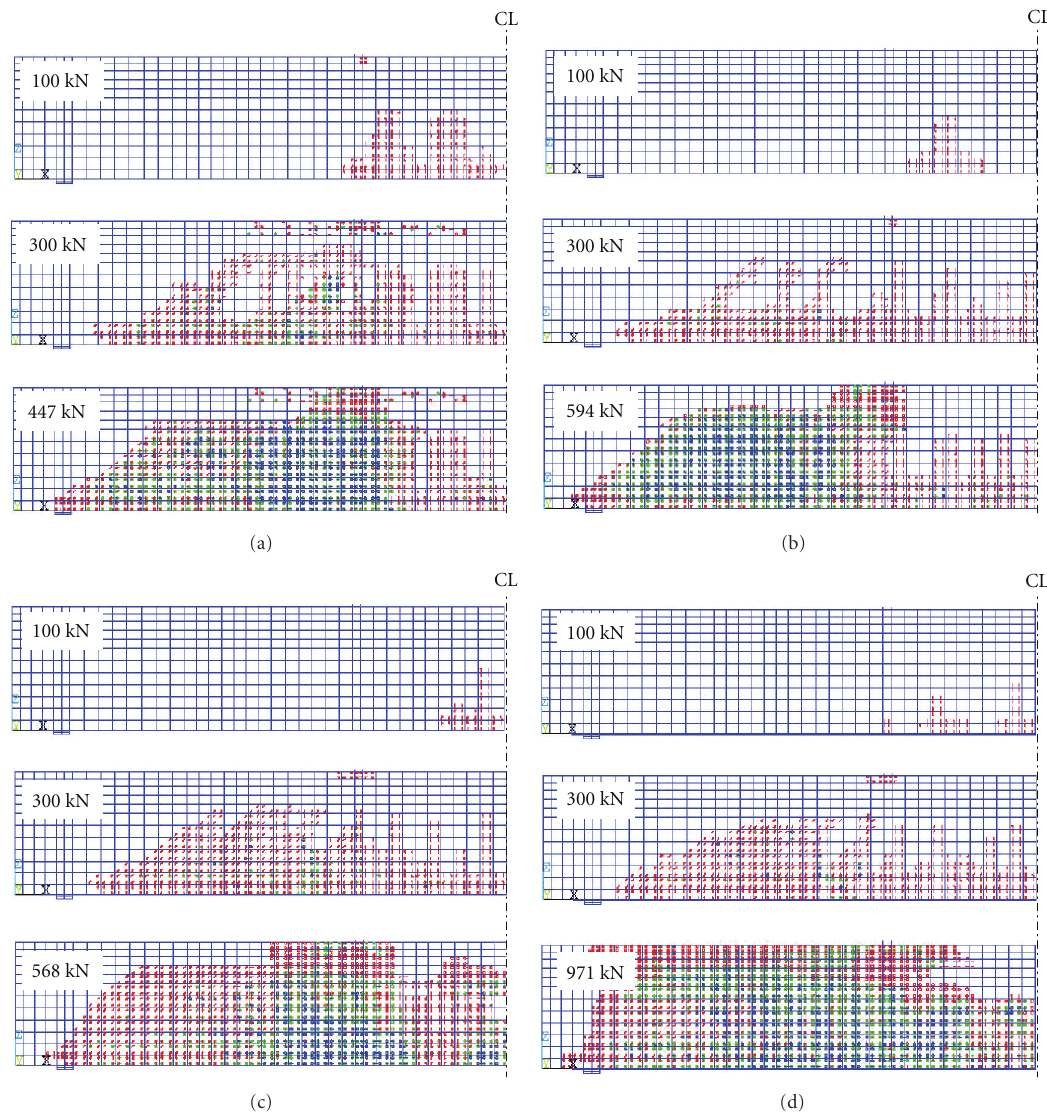
Figure 9: Evolution of crack patterns: (a) Unstrengthened beam; (b) flexural-strengthened beam; (c) shear-strengthened beam; (d) flexural plus shear-strengthened